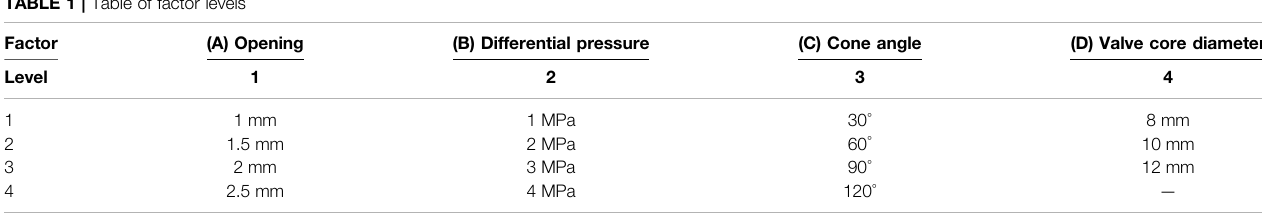
TABLE 2 | Orthogonal test table Test